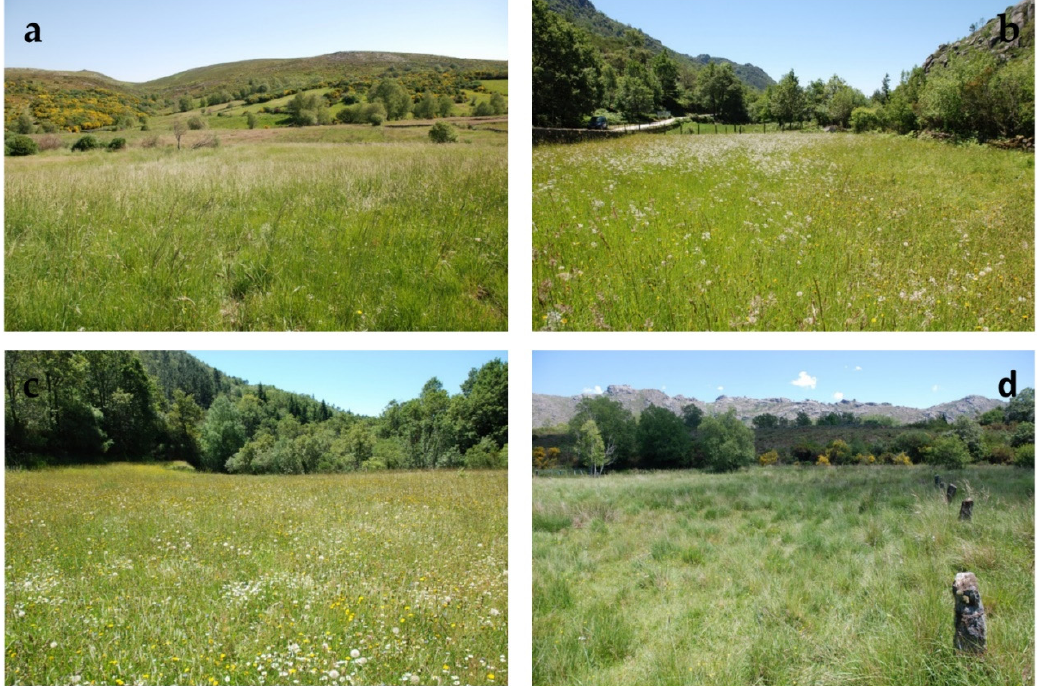
Figure 2. Examples of the different types of grasslands surveyed in the study area located in the Portuguese Peneda-Ger ê s National Park (photos were taken during the field survey mid-end of June 2016). Photo ( a ) shows the mesic grasslands, ( b ) meso-hydrophilic grasslands, ( c ) meso-xerophytic and ( d ) hygrophilic